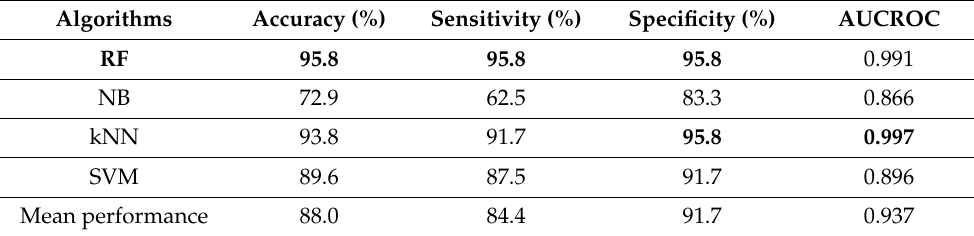
Table 4. Results using laboratory features after the SMOTE technique in predicting long-term medical